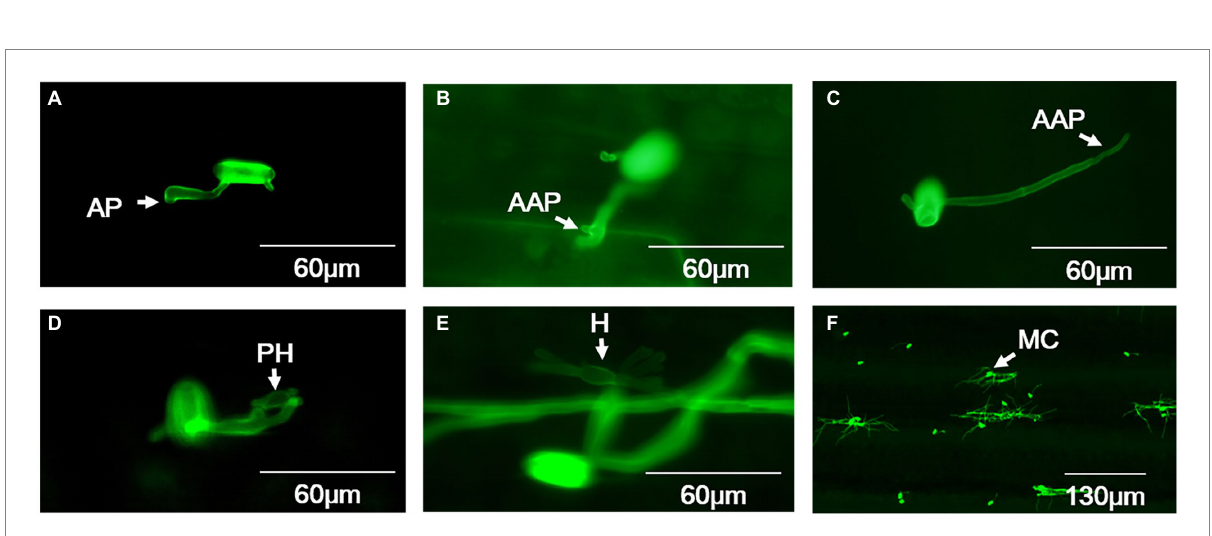
a DnaK domain in 3 homologous Bgthsp70 genes, a HSP83 domain in Bgthsp90 gene, and a ClpB domain in both 2 homologous Bgthsp104 genes. Subcellular localization prediction by WoLF PSORT showed that HSP60 was localized in mitochondria, and HSP70a, HSP70b, HSP90, HSP104a, and HSP104b were localized in cytoplasm, while HSP70c was localized in endoplasmic reticulum (ER; Table 4). genes expression levels at 24, 48, and 72 hpi at 18 ° C and 25 ° C. At